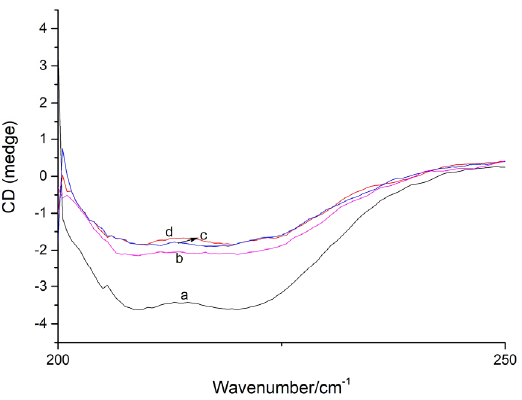
Figure 8. The CD spectra of XO and viniferifuran–XO. XO = 0.1 U/mL; viniferifuran = 0, 1, 5, and 10 µ M for curves a to d, respectively. Table 2. The contents of different secondary structures of XO and its viniferifuran complex calculated from CD